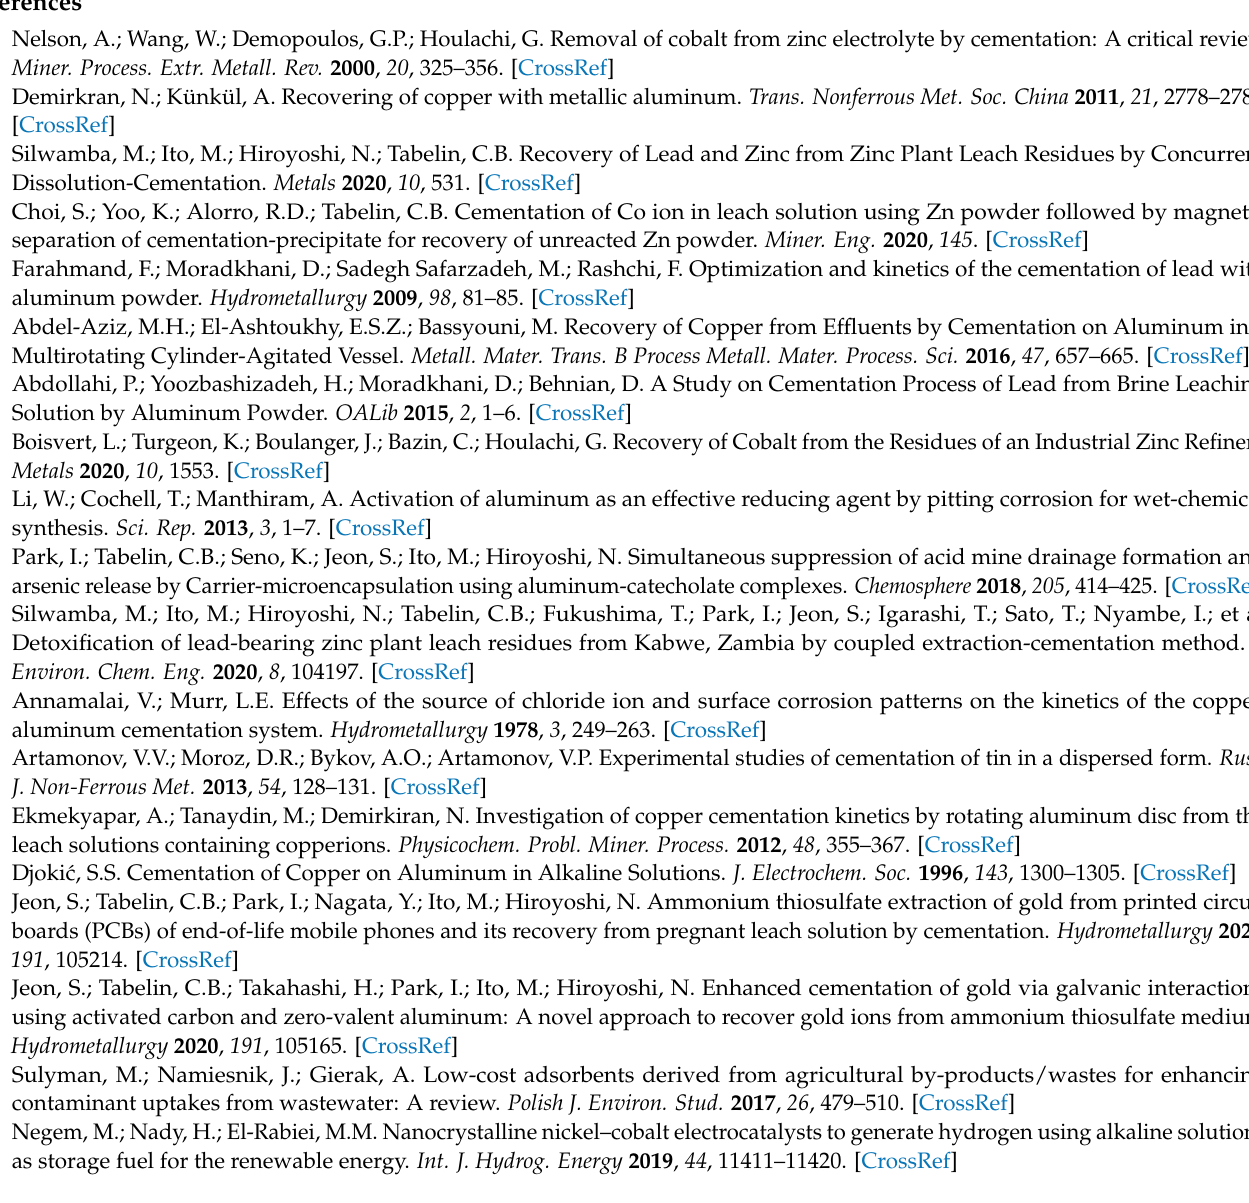
using the GWB Professional Ver. 12.0.3 software), Figure S2: The activity–pH diagram for 1 mM Ni 2+ species with 0.1 M SO 42– at 25 ◦ C (created using the GWB Professional Ver. 12.0.3 software), Figure S3: The activity–pH diagram for 1 mM Co 2+ species with 0.1 M Cl – at 25 ◦ C (created using the GWB Professional Ver. 12.0.3 software), Figure S4: The activity–pH diagram for 1 mM Ni 2+ species with 0.1 M Cl – at 25 ◦ C (created using the GWB Professional Ver. 12.0.3